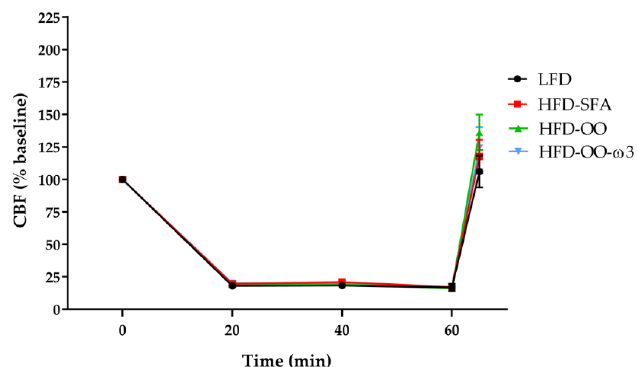
Figure 3. Representation of cerebral blood flow (CBF) traces recorded by laser Doppler flowmetry during the tMCAo procedure. CBF values were recorded continuously during the procedure, analysing the following time intervals: baseline (0 min), 0–20 min, 20–40 min, 40–60 min, and the onset of reperfusion at 60–65 min. Groups: LFD (Black), HFD-SFA (Red), HFD-OO (Green) and HFD-OO- ω 3 (Blue). No significant di ff erences between the groups were found (2-way ANOVA), the results represent the mean ± SEM of 8 to 10 animals. Low-fat diet ( LFD ), high-fat diet rich in saturated fatty acids ( HFD-SFA ), high-fat diet rich in olive oil ( HFD-OO ), and high-fat diet rich in olive oil plus DHA and EPA ( HFD-OO- ω 3 ).